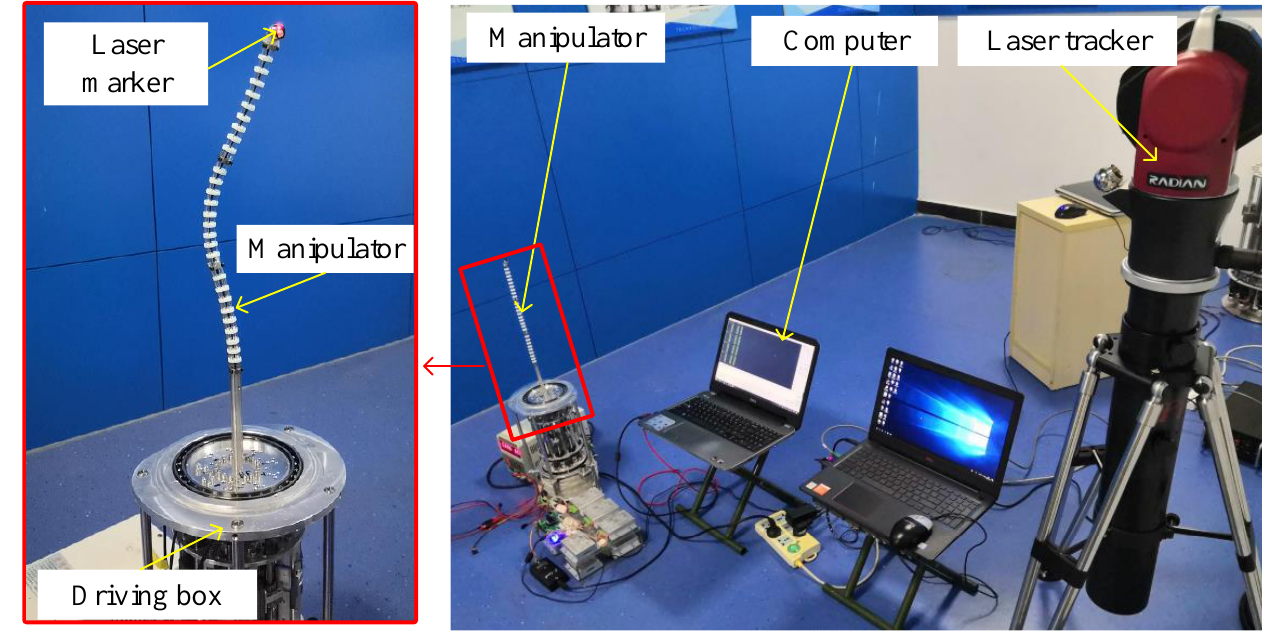
Figure 18. Setup of the circle trajectory following experiment.